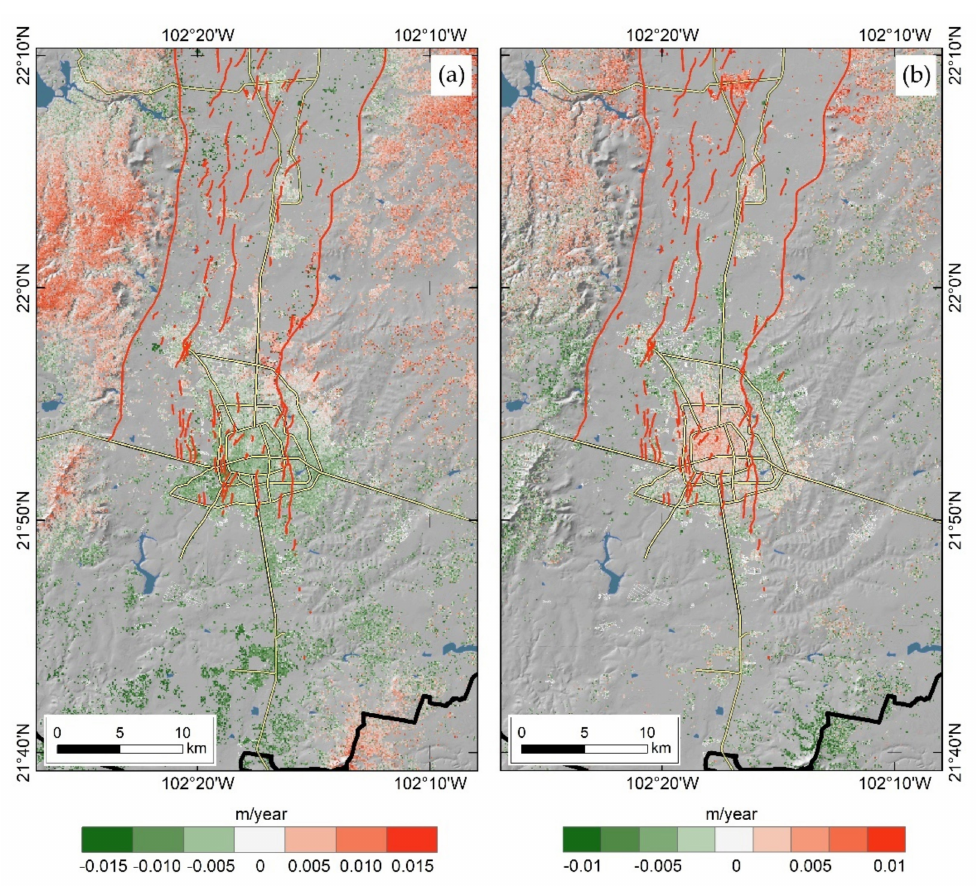
Figure 9. Differences between SBAS and PSI velocities. ( a ) PSI-SBAS differences in up ( ∆ V U ) direction and ( b ) SBAS-PSI differences in east-west ( ∆ V E ) direction.